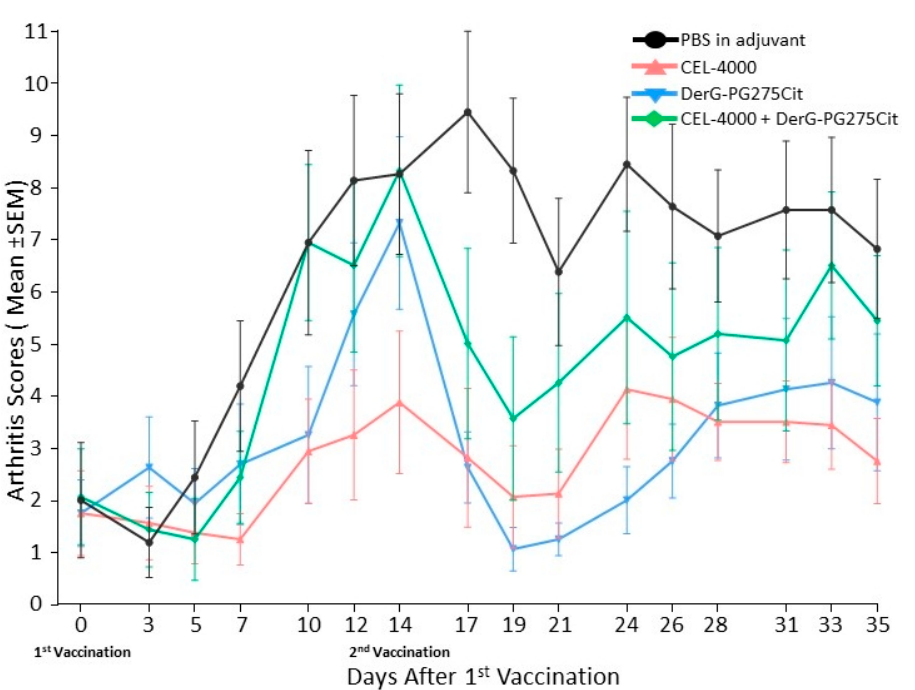
Figure 4. Therapeutic effects of LEAPS vaccine treatment on arthritis in GIA mice in the confirmatory study (study 2). LEAPS therapy was initiated in the GIA model after the onset of arthritis. The groups and treatment protocols for control (adjuvant) and LEAPS administration were the same as in Figure 2. Disease severity was significantly suppressed (as indicated by reduced arthritis score) in mice treated with LEAPS vaccines as compared with the adjuvant-treated control group ( n = 8 mice per group). The 2-way repeated measures ANOVA was used for statistical analysis (see Supplemental Table S2 for p values of visual arthritis scores and other details).